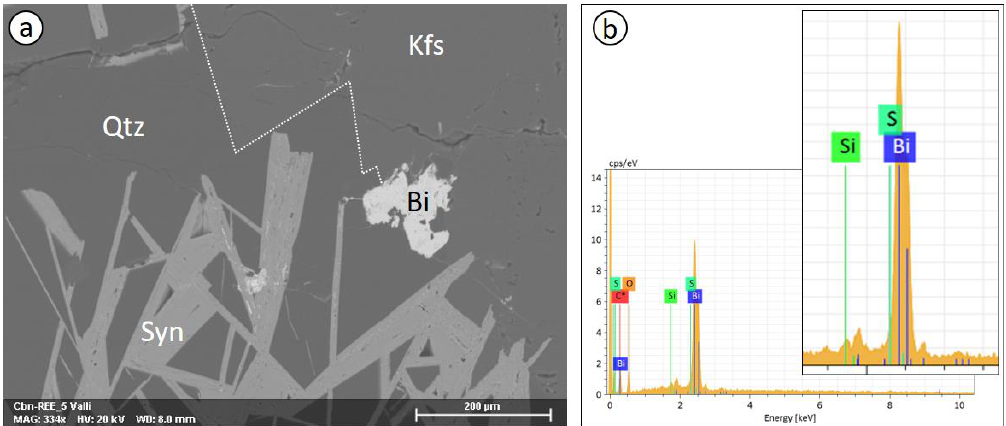
Figure 4. ( a ) Backscattered electron (BSE) SEM image of a sample from Cinquevalli showing randomly oriented, needle-like crystals of synchysite-(Ce) (Syn) embedded in quartz (Qtz) and K-feldspar (Kfs). The saw-teeth contact between Qtz and Kfs is marked by a dotted line in the central top part of the image. Rarer aggregates of metallic bismuth (Bi) are also observed. ( b ) EDS spectrum of the bismuth grain (Bi) imaged in ( a ) showing the lack of the S peak.